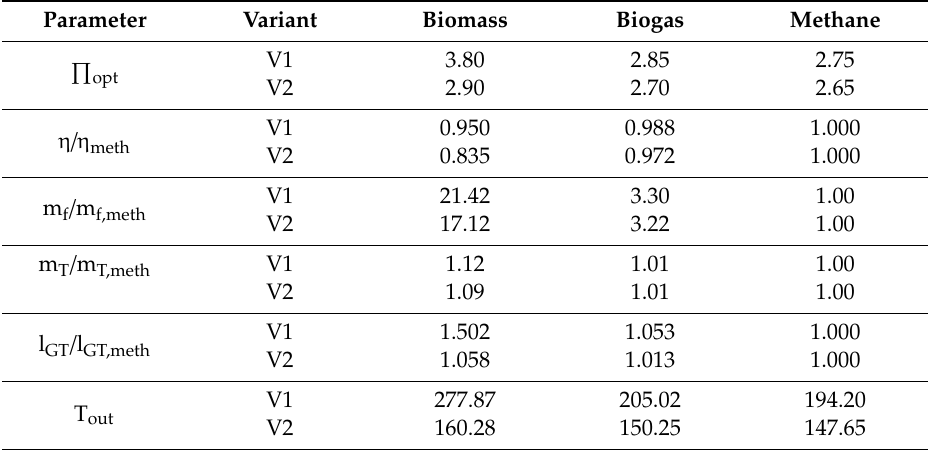
Table 5. Summary of the results of calculations carried out for the di ff erent calorific values. Parameter Variant Biomass Biogas Methane